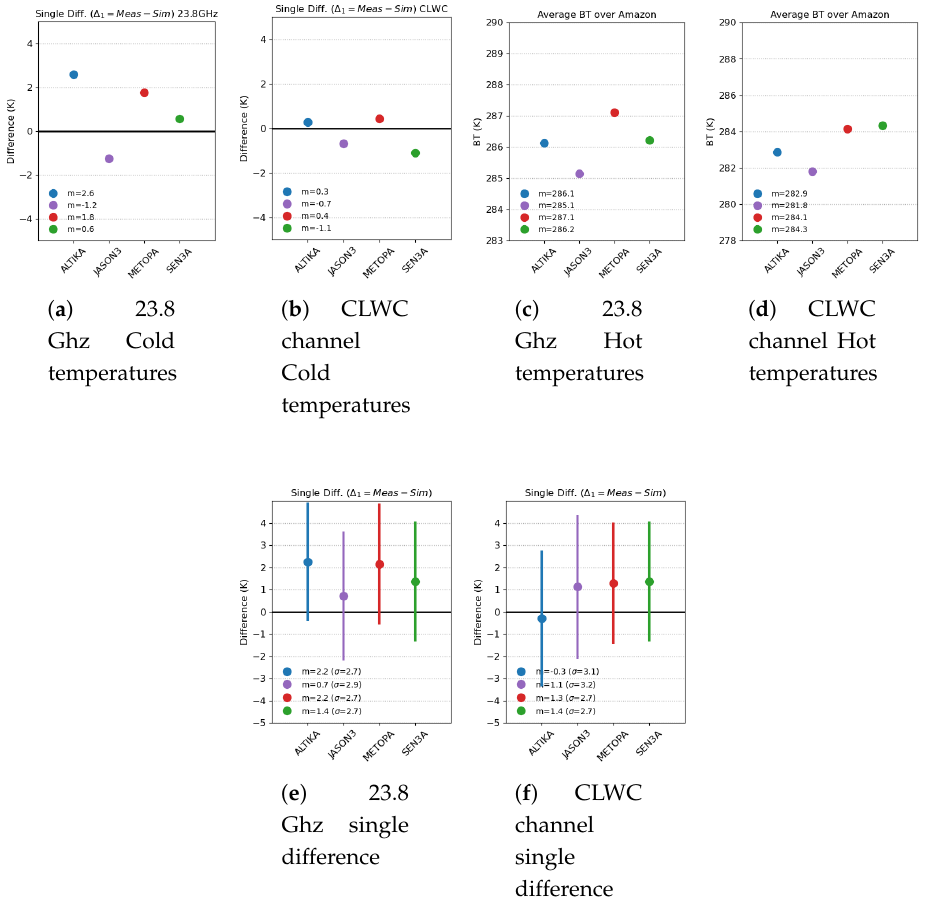
Figure 10. Mean temperatures of single difference for coldest ocean points ( a , b ), hottest temperatures over Amazon forest ( c , d ) and single difference over ocean ( e , f ) after in-flight